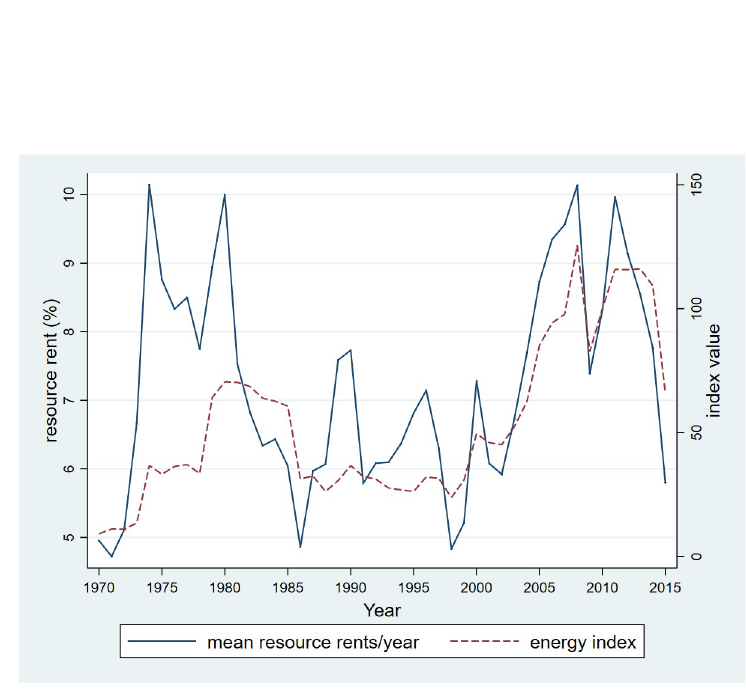
Fig 1. Relationship between energy index and resource rents. Data source: World Development Indicators (WDI) and The World Bank Commodity Price Data (The Pink sheet).